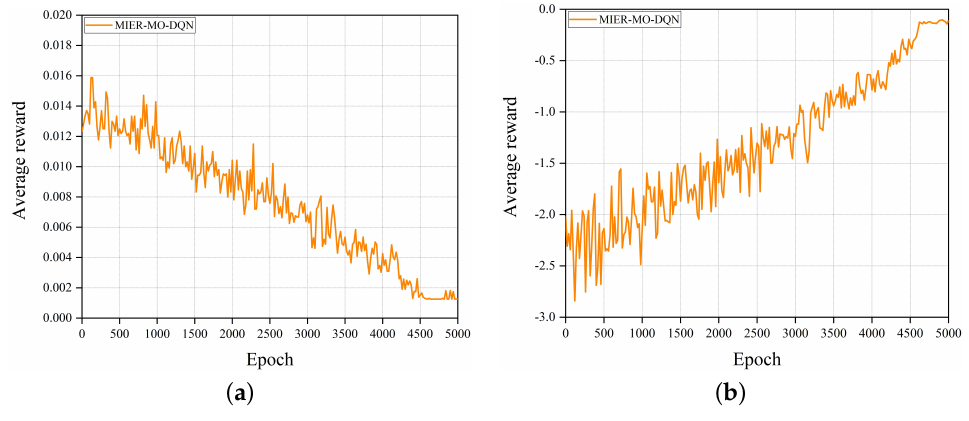
Figure 12. Average reward of ( a ) r 1 , ( b ) r 2